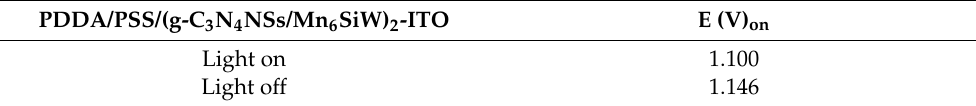
Table 2. The catalytic potential of PDDA/PSS/(g-C 3 N 4 NSs/Mn 6 SiW) 2 -ITO electrode.